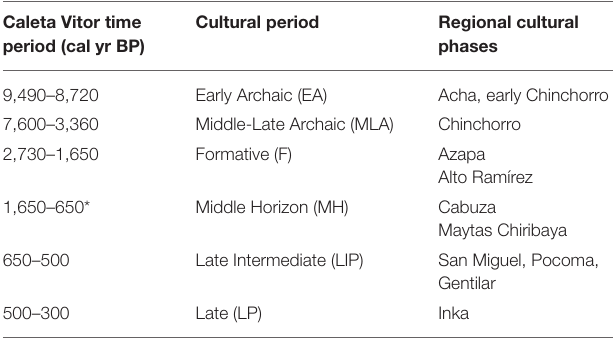
TABLE 1 | Chronology, time period, and socio-cultural phases based on AMS dating from Caleta